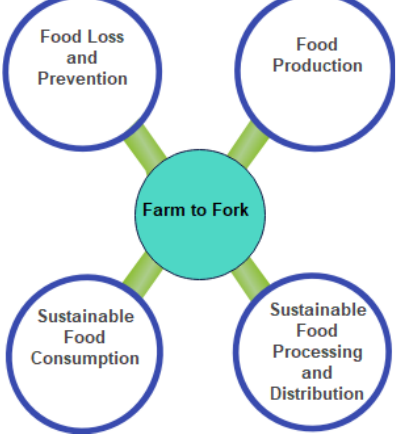
Figure 1. Farm-to-fork strategy.